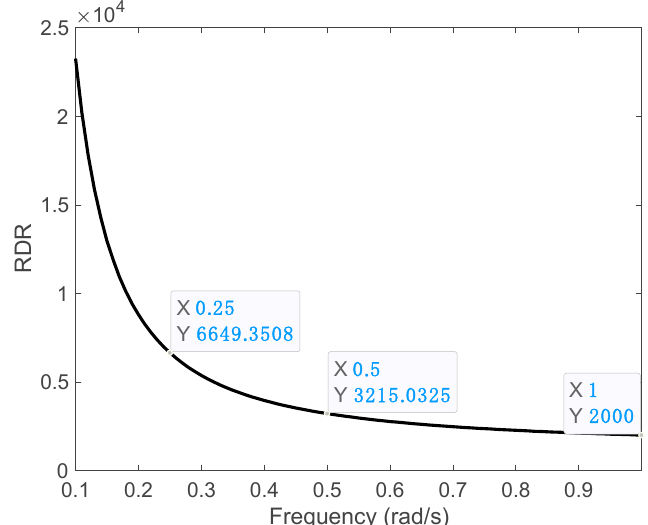
Figure 14. RDR vs. disturbance frequency signal spectra for an FOPDT process.